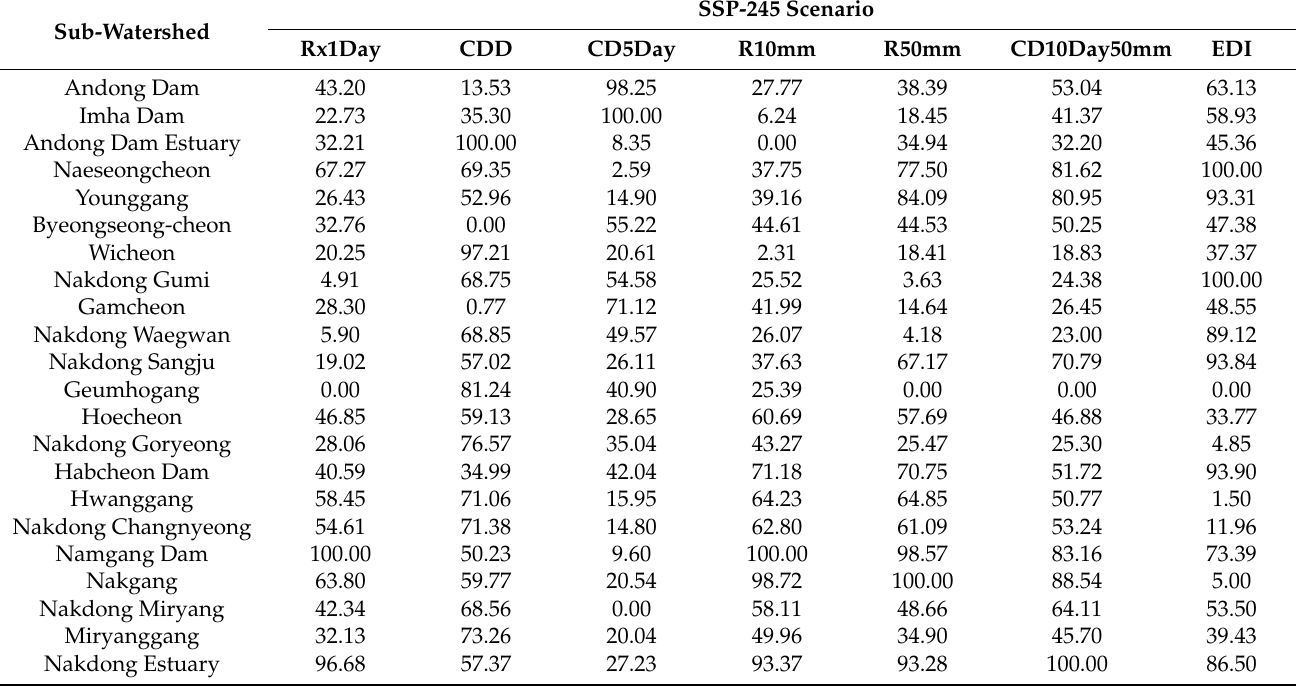
Table 6. Standardized indices of climate change exposure in scenario